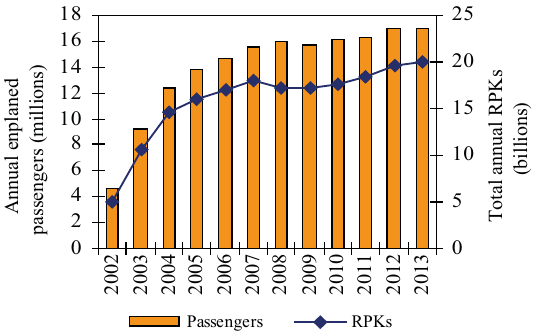
Fig. 5. Development of “Virgin Australia” domestic passengers and revenue passenger kilometres (RPKs): 2002–2013. Note : 2002 data for 9 months (“Virgin Australia”, “Virgin